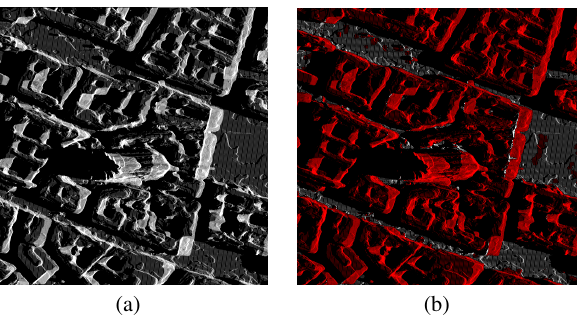
Figure 6. Frauenkirche in Munich. (a) displays the simulated SAR image using the preprocessed DSM; (b) shows the simu- lated building extent based on the building DSM as input, being overlaid on the simulated image.